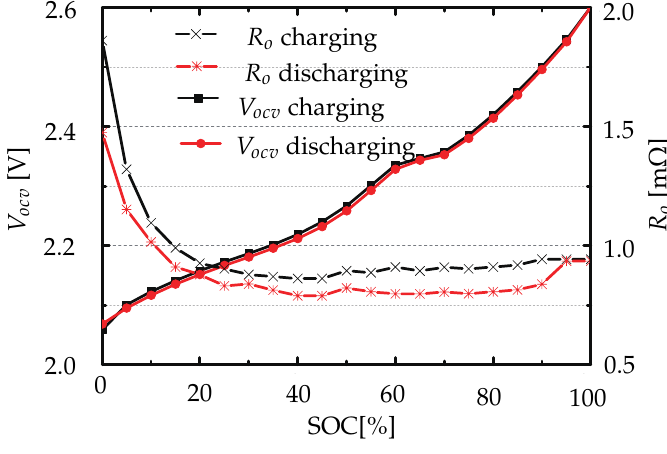
Figure 5. Parameters V ocv and R o in the 8.5 Ah Thevenin battery circuit